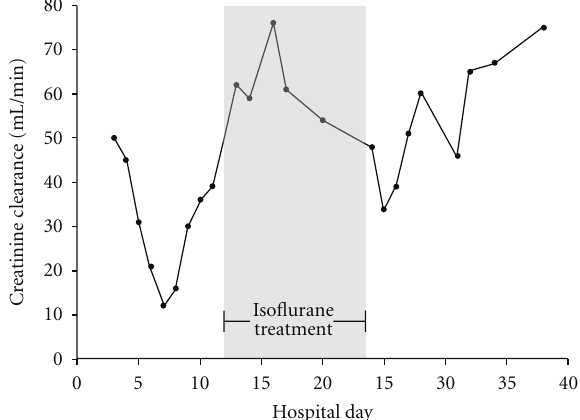
Figure 1: Creatinine clearance of the patient during hospital treatment. Time of isoflurane treatment is indicated by grey